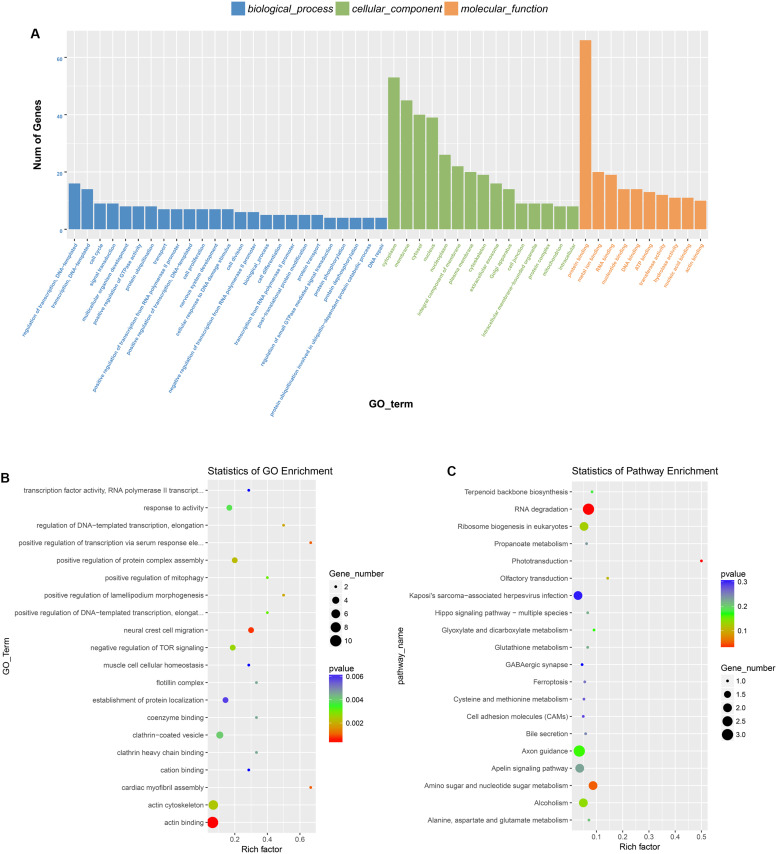
GO and KEGG pathway analysis of the parental genes of the identified circRNAs. (A) The top 25 GO BP, top 15 GO CC, and top 10 GO MF are displayed. (B) The top 20 most represented significant GO terms are displayed in a scatter plot. (C) The top 20 enriched KEGG pathways of the circRNA parental genes.